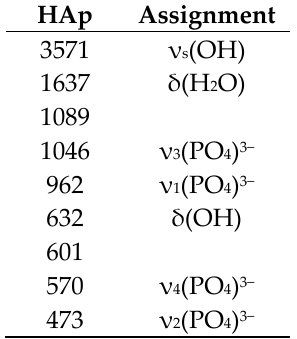
Table 1. Experimental absorption in the infrared spectrum and relative assignments for hydroxyapatite